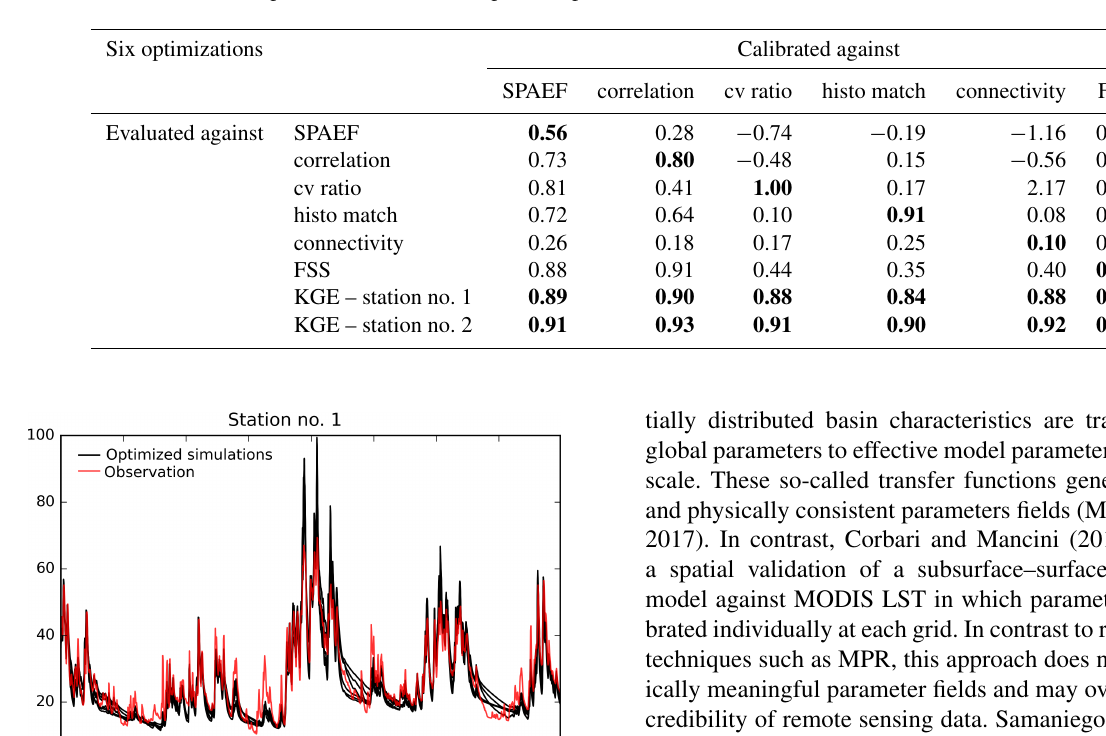
Table 1. Cross-check of the six conducted calibrations (as rows). The optimal model run is evaluated by the remaining metrics (as columns). Numbers in bold indicate the optimized value of the respective optimization.